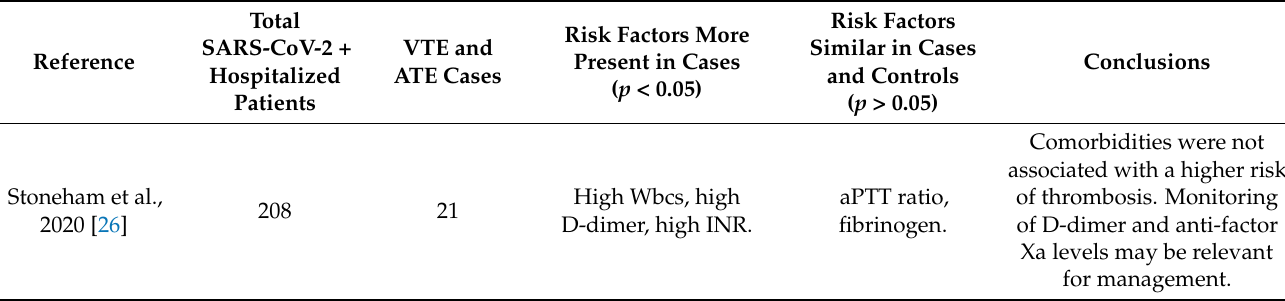
Table 1. 2020 case-control retrospective studies comparing risk factors for thrombosis development in hospitalized patients with severe Covid-19 (controls) versus hospitalized patients with both severe infection and DVT or ATE (cases). VTE: venous thromboembolism, ATE: arterial thromboembolism, WBCs: white blood cells, INR: international normalized ratio, aPTT: activated partial thromboplastin time, CRP: C reactive protein, ICU: intensive care unit, CTPA: CT pulmonary angiography, IL-6: interleukin-6, DVT: deep vein thrombosis, IMV: invasive mechanical